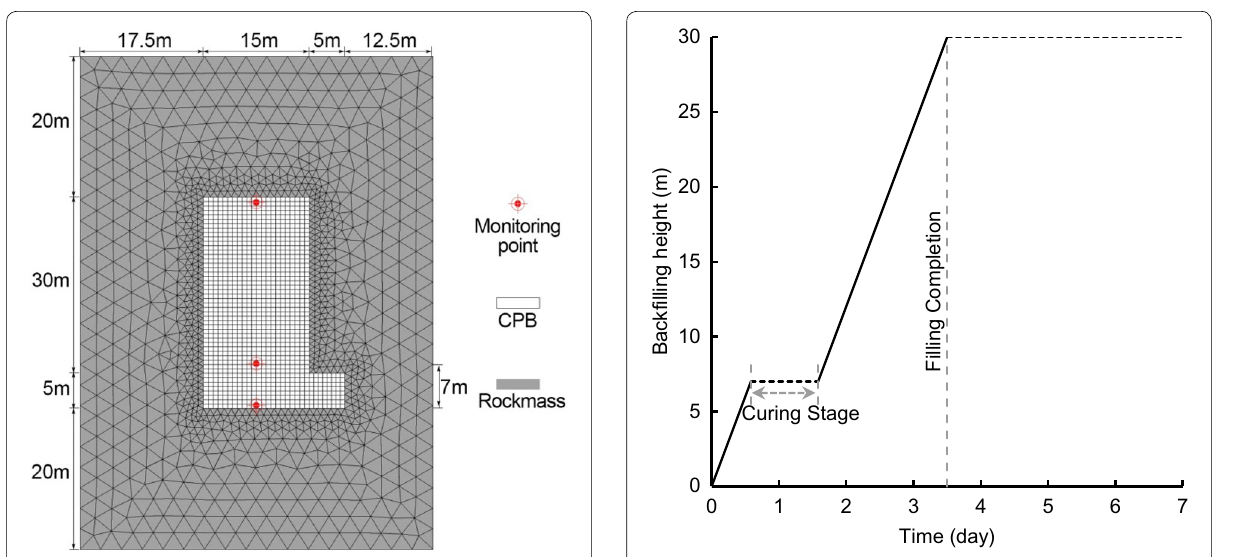
Fig. 9 Mesh and geometry of control CPB and stope Fig. 10 Backfilling operation for the control stope